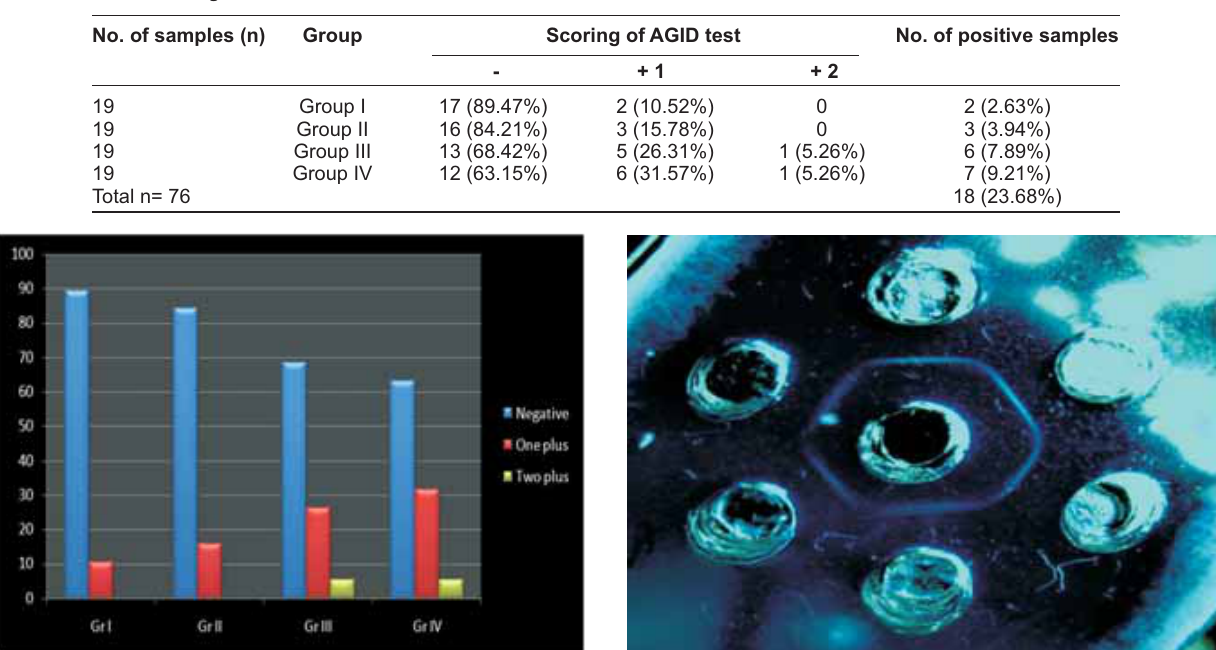
Table-4: Details of Agar Gel immunodiffusion test